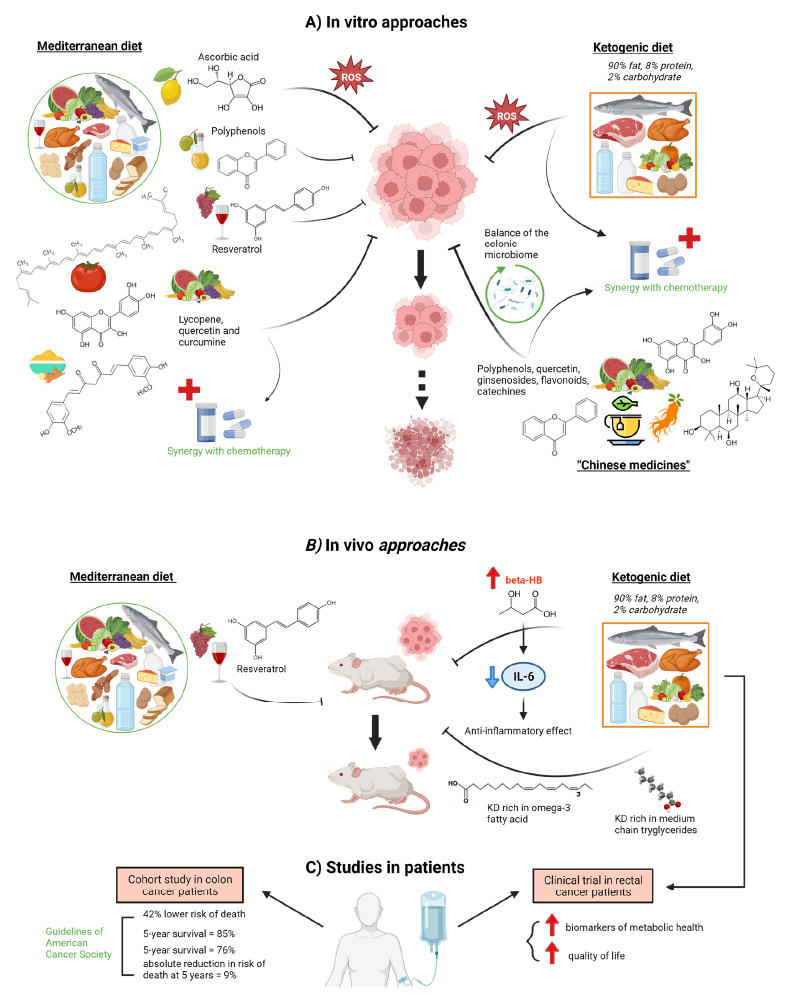
Figure 1. Effects of various diet components derived from the Mediterranean diet, Ketogenic diet, or Chinese medicine on colorectal cancer cells. ( A ) In vitro experiments showed the effects of Mediterranean diet components such as ascorbic acid, polyphenols, resveratrol, lycopene, quercetin, and curcumin on the proliferation of CRC cells [33,35–38]. Moreover, lycopene, quercetin, and curcumin also showed synergy with chemotherapy treatments [38]. Similarly, a ketogenic diet enhances tumor cell vs. normal cell sensitivity to radiation and chemotherapy by a mechanism involving oxidative stress [26,31]. In addition, Chinese medicines are able to improve life quality and exert anti-cancer effects by exerting synergies in CRC chemotherapy administration as well as modulating the microbiome balance, which contributes to host well-being [38–40]. ( B ) Through in vivo experiments, the inhibition of the invasion and metastasis of colon cancer by resveratrol [37] and the effects of a ketogenic diet on inflammation and cancer progression, and tumor inhibition have been demonstrated [41,42]. ( C ) Clinical studies showed that a lifestyle consistent with the American Cancer Society (ACS) guidelines is associated with better survival in colon cancer patients [43] as well as a better quality of life in rectal cancer patients on a ketogenic diet [44]. Dot arrow means possibility event. Created with BioRender.com (accessed on 14 April